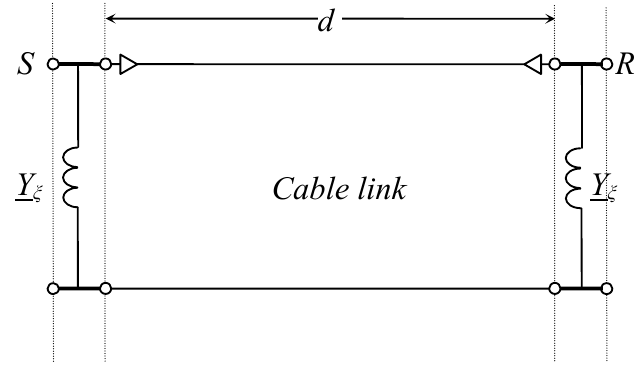
Figure 1. Lumped shunt compensation at the two